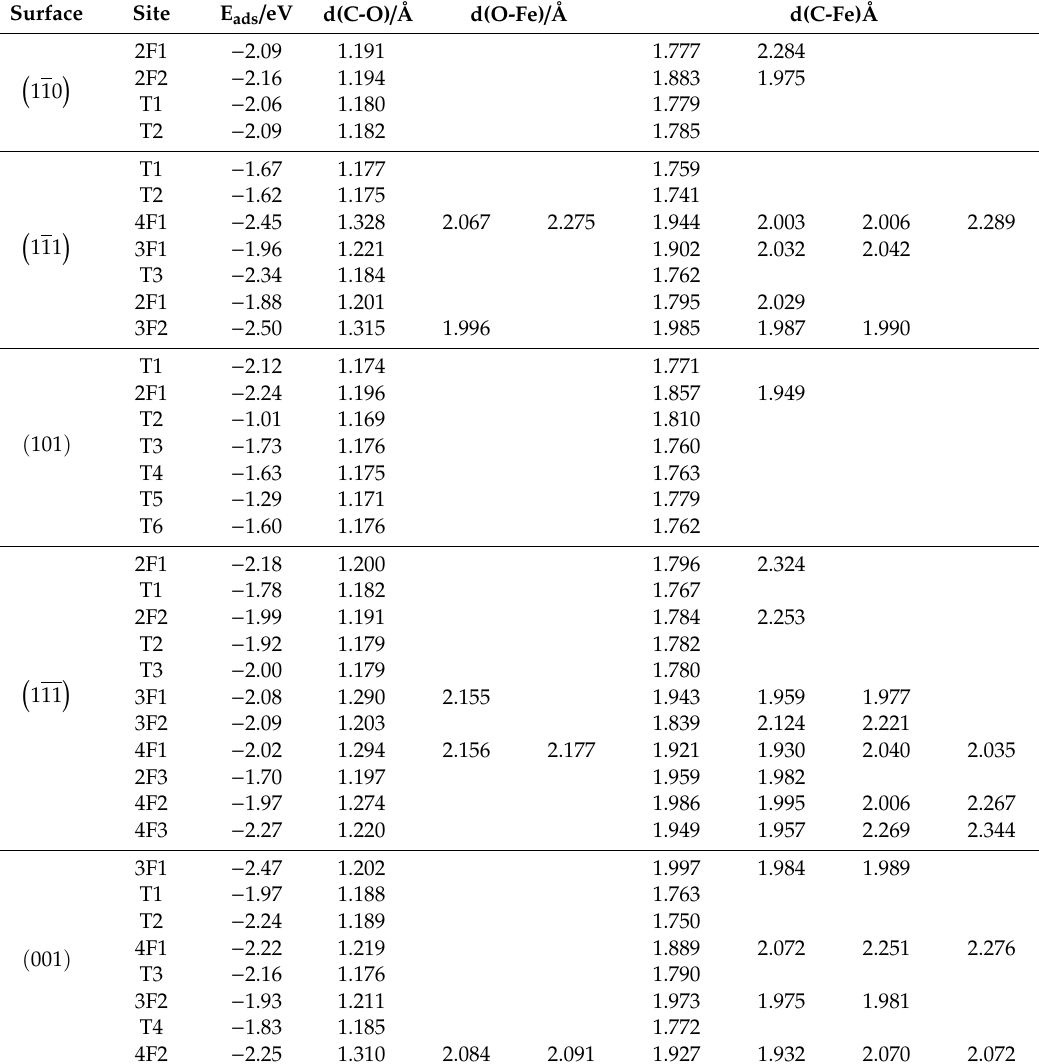
Table 3. Absorption energy and bond lengths of five CO adsorption point positions on the h-Fe 7 C 3